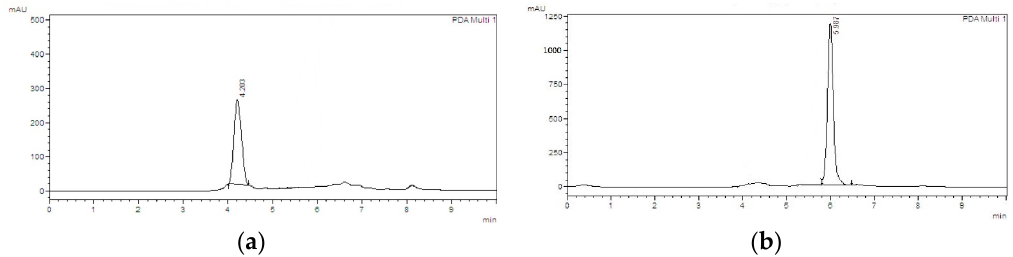
Figure 4. HPLC chromatographs of punicalin ( a ) and punicalagin ( b ) standards. Chromatograph was run on a Shimadzu LC-20AT HPLC equipped with a SPD-M20A PDA detection system. Separations were carried out on a Dr. Maisch GmbH C18 (Ammerbuch-Entringen, Germany) column (5 μ m, 250 mm × 4.6 mm), 25 °C, with a mobile phase of 0.1% ( v / v ) aqueous solution of phosphoric acid and acetonitrile (80:20). The mobile phase flow rate was 1 mL/min with 10 min run time. The standards were detected using a wavelength of 254 nm. Sample injection volume was 10 μ L. Retention times for punicalin and punicalagin were 4.203 and 5.987 min, respectively.